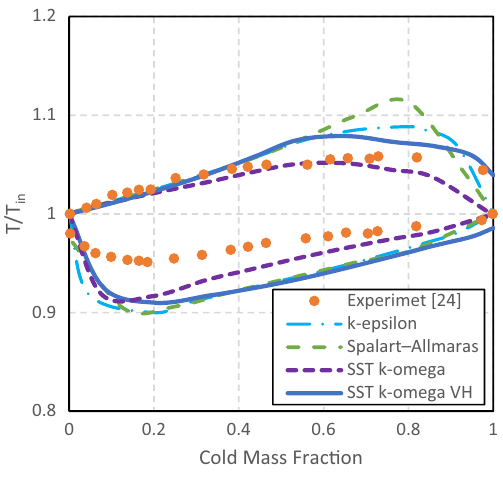
Fig. 4 Validating the of different turbulence numerical models with the experimental data in [24] by plotting outlet total temperature ratio from numerical study and experiment recovery temperature with respect to mass fraction (temperature ratio greater than one is for hot outlet and temperature ratio less than is for cold